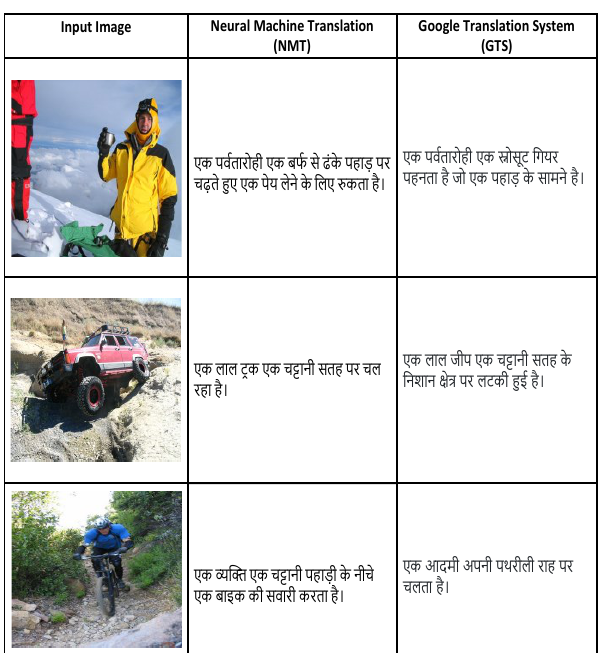
Table 1. Comparison of the proposed NMT Model with